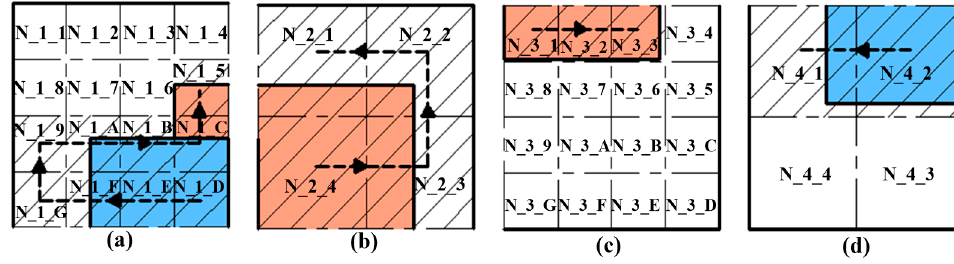
Figure 4. ( a – d ) The divided sub-regions and scanning trajectories of the region N_1–N_4.